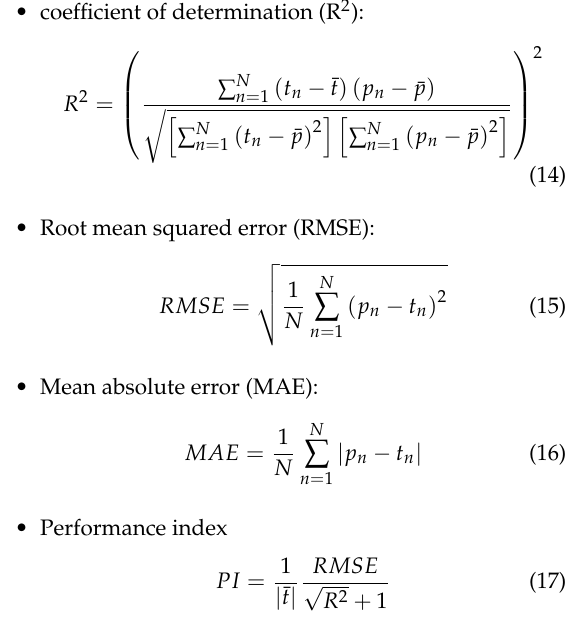
Fig. 7. The process of the hybrid